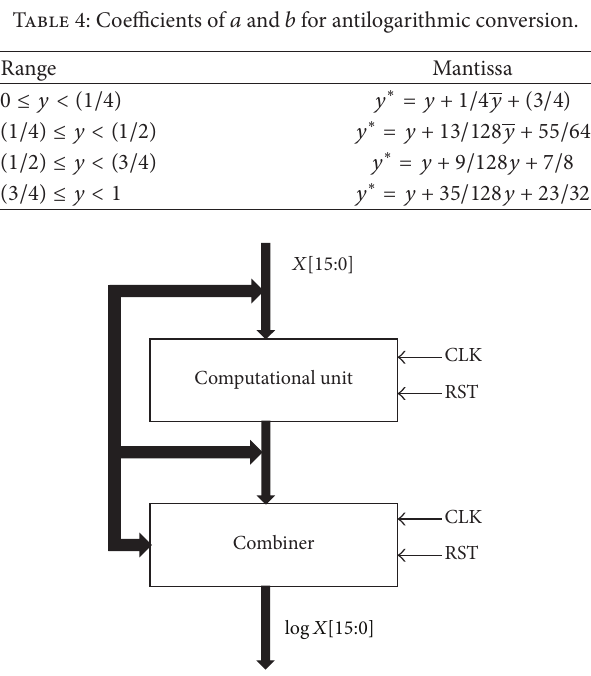
Figure 2: LOGC and ALOGC basic architecture block